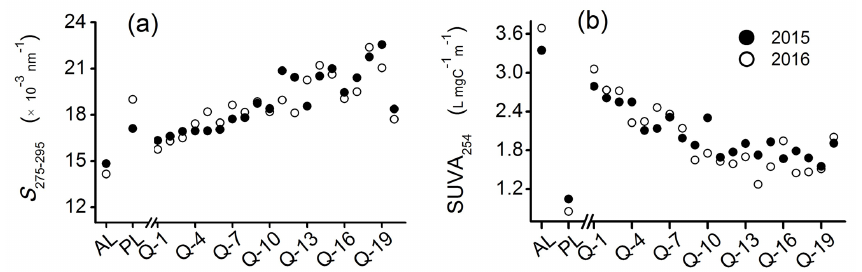
Figure 3. UV–visible optical indices of the stream water and PL and AL leachate samples collected in 2015 (filled circles) and 2016 (open circles) on the QTP: S 275 − 295 (a) and SUVA 254 (b)